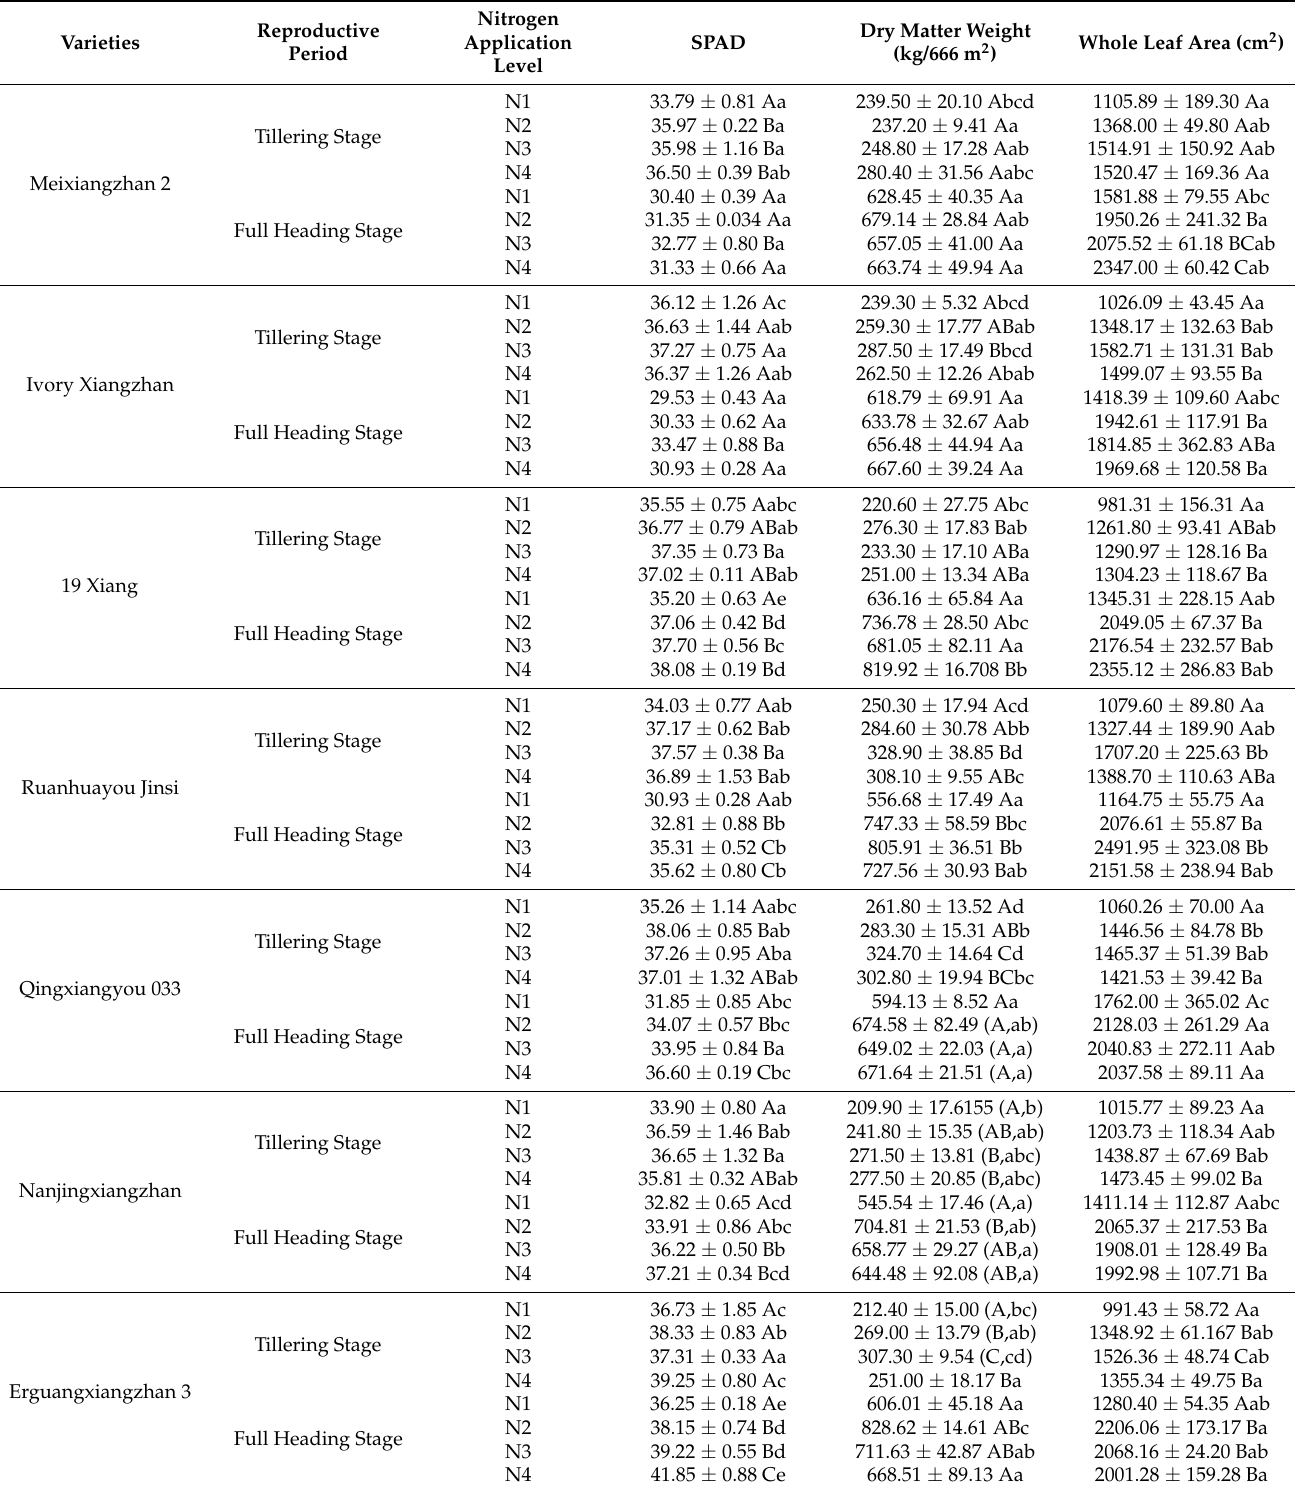
Table A1. Analysis of Variance of Physiological Parameters of